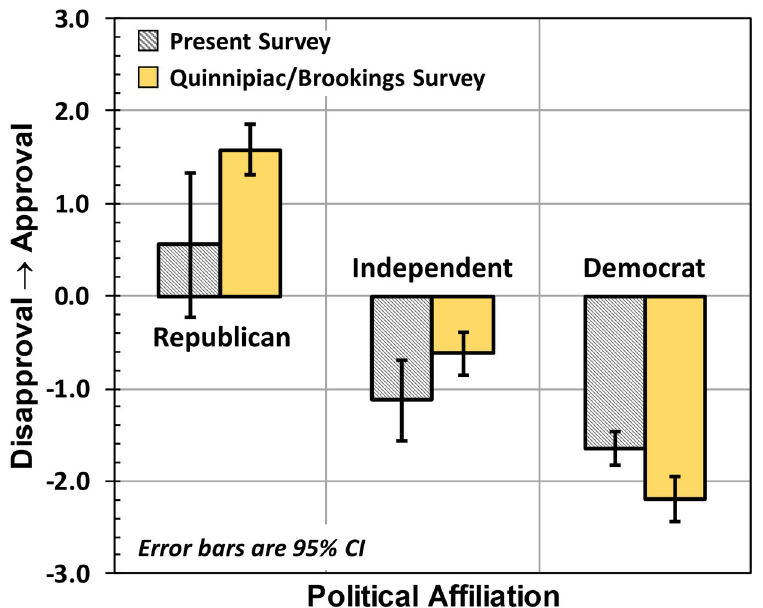
Fig 1. Study-1 results regarding approval of Donald Trump’s presidency, which are consistent with the Brookings Institute and Quinnipiac results.